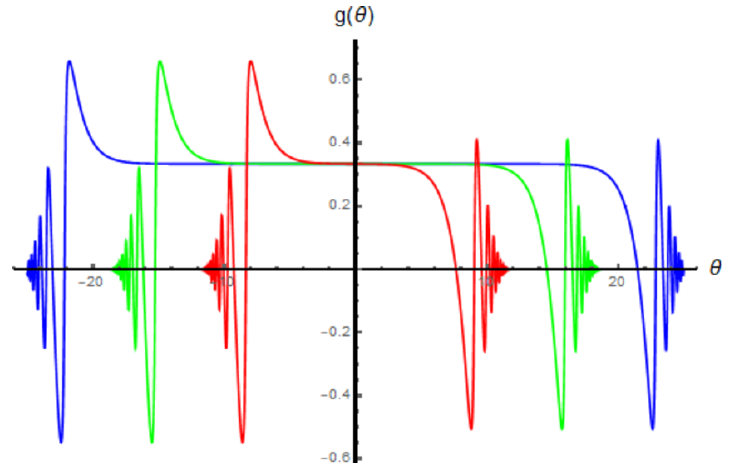
I m (ln(1 + e (cid:0) f (cid:23) ( (cid:18) + i 0 + ) )) as m ! 0 at 2 (cid:25)